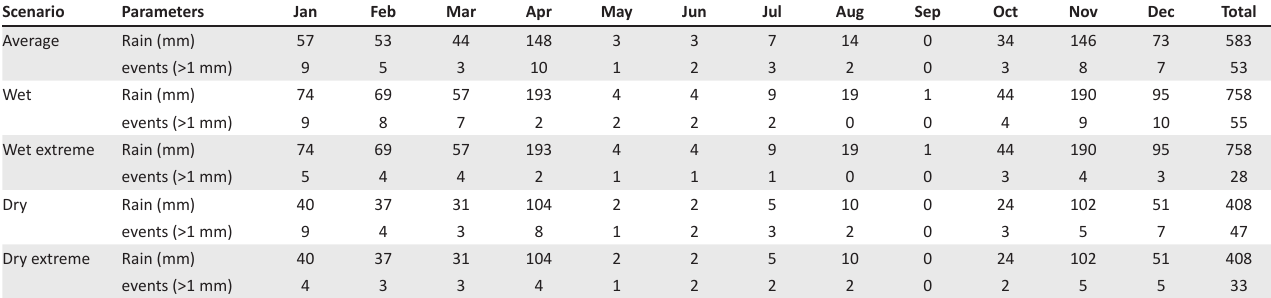
TABLE 3: Average monthly values for precipitation scenarios. Scenario Parameters